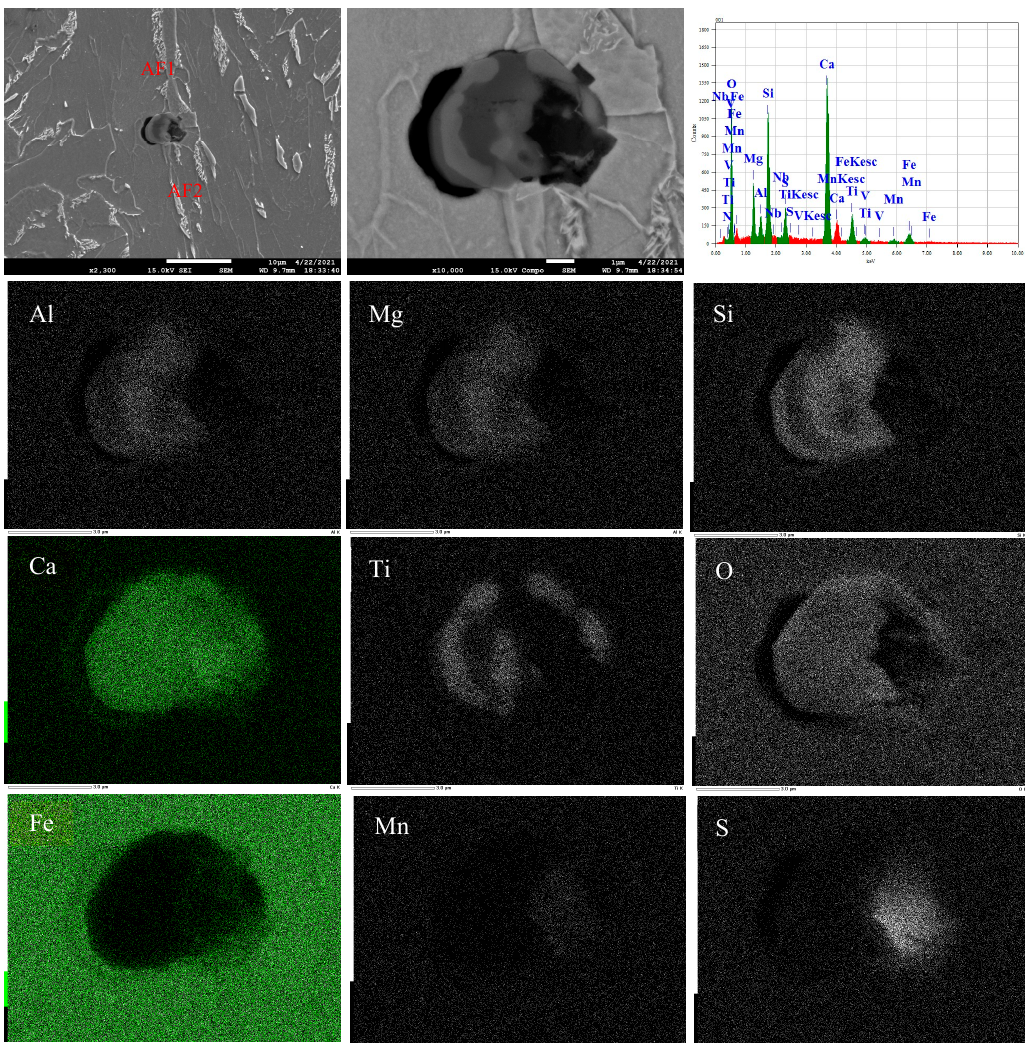
Figure 18. EDS mapping analysis of one typical inclusion B effective for IAF nucleation in Ti-Ca deoxidized steel.